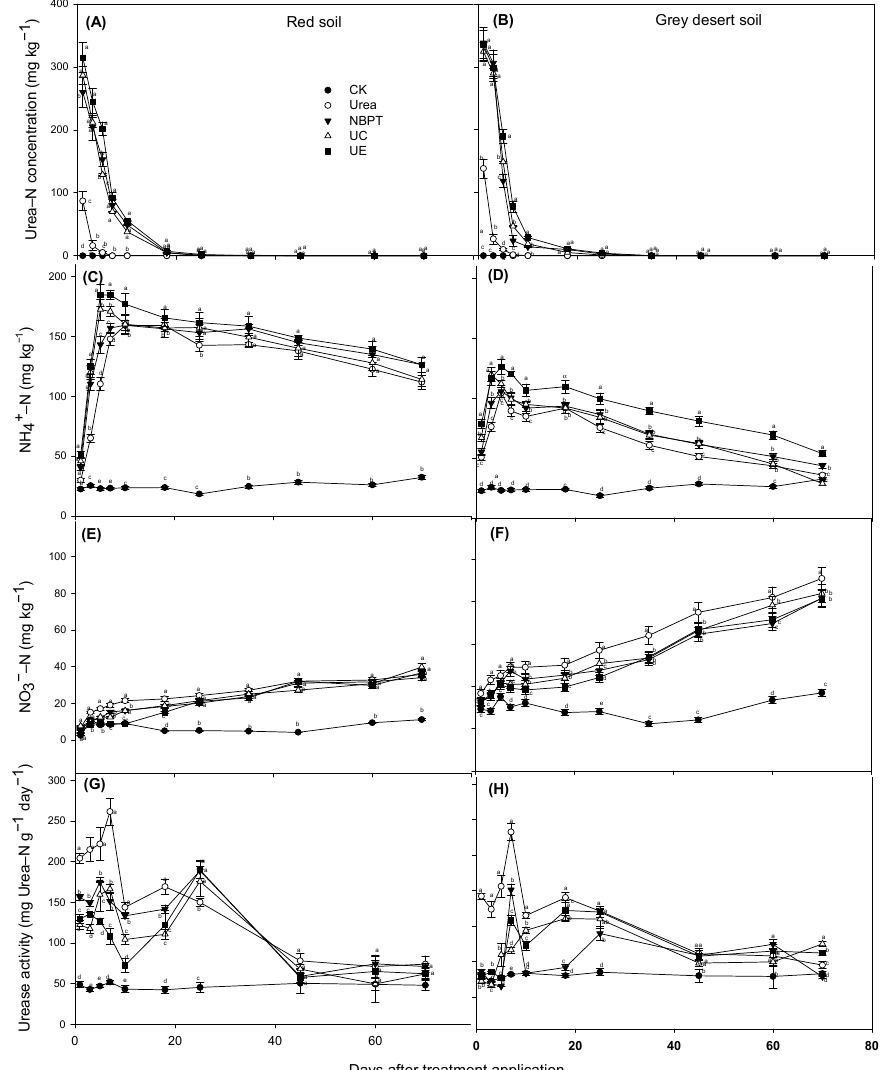
Figure 2. The dynamics of urea, NH 4+ , and NO 3- concentrations, and urease activity in red ( A , C , E , G ) and grey desert soils ( B , D , F , H ) receiving five treatments. Data are presented as mean values with standard errors (n = 3). CK, no N fertilizer control; Urea, urea application alone; NBPT, urea + NBPT; UC, urea + 2-Cyclopenten-1-one; UE, and urea +Eugenol. (Different letters indicate significant differences ( p < 0.05) among treatments at the same sampling day.)